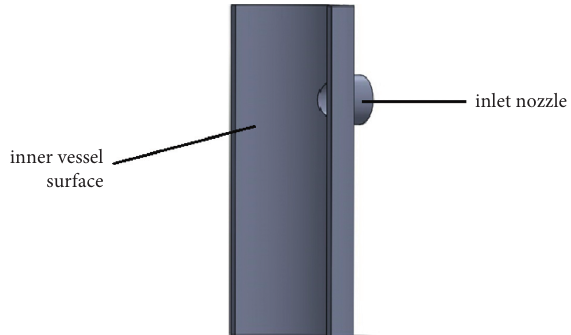
Figure 5: Geometry of the RPV with an inlet nozzle.